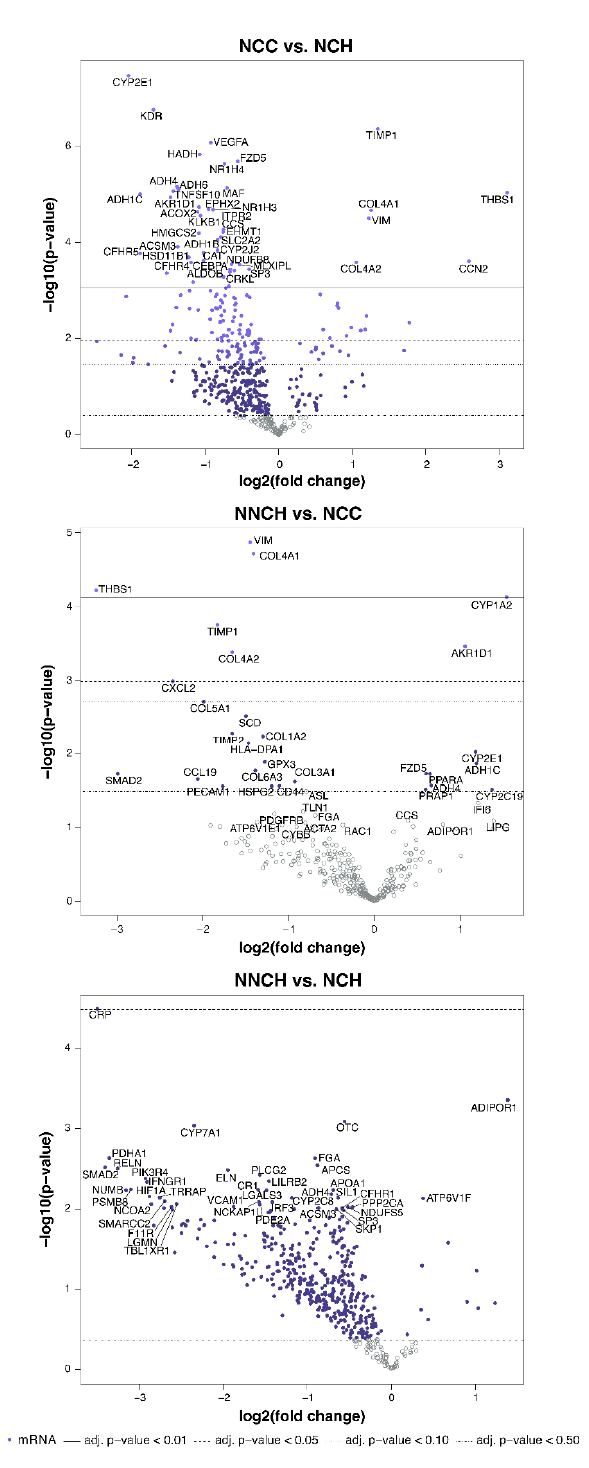
Figure 3. Volcano plots of differentially expressed genes between patient groups.